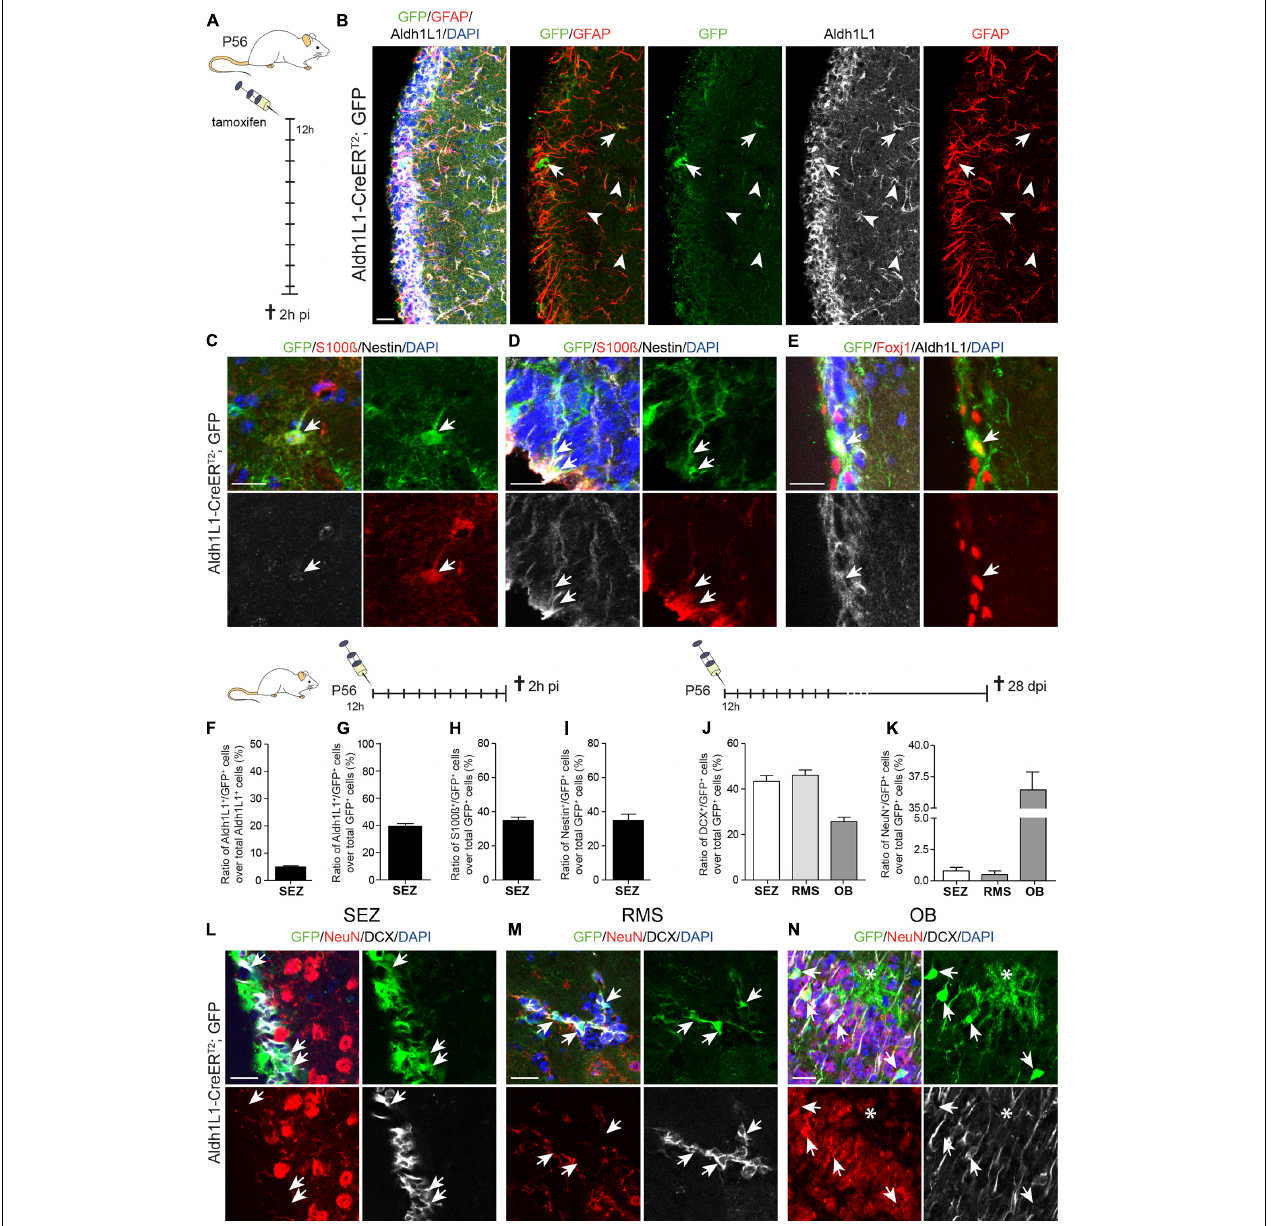
FIGURE 3 | Recombination in Aldh1L1-CreER T2 ; GFP mice targets astrocytes and neural stem cells in the subependymal zone. (A) Schematic drawing showing the short-term tamoxifen pulse. Here, Aldh1L1-CreER T2 ; GFP mice were injected with tamoxifen every 12 h (12 h) for five consecutive days and killed 2 h post-injection (2 h pi). (B) Representative pictures illustrate an overview of the immunohistochemically stained SEZ of adult Aldh1L1-CreER T2 ; GFP mice. Arrows point toward GFP/GFAP/Aldh1L1 triple positive cells while arrowheads highlight non-recombined GFAP + /Aldh1L1 + cells (DAPI in blue, GFP in green, GFAP in red, Aldh1L1 in white; scale bar = 20 µ m). (C,D) Representative images show an immunohistochemically stained SEZ of Aldh1L1-CreER T2 , GFP transgenic mice using antibodies directed against GFP (green), S100 β (red), and Nestin (white). The arrows point toward a GFP/S100 β double positive astrocyte in the SEZ (C) , or a triple positive radial glia-like NSC (D) DAPI is depicted in blue, scale bar = 20 µ m. (E) Images show an immunohistochemically stained SEZ of Aldh1L1-CreER T2 , GFP transgenic mice using antibodies directed against GFP (green), FoxJ1 (red), and Aldh1L1 (white). The arrows point toward a triple positive ependymal cell. DAPI is depicted in blue, scale bar = 20 µ m. (F,G) Efficiency and specificity of recombination are expressed as the ratio of Aldh1L1/GFP double positive cells over all Aldh1L1 + or GFP + cells, respectively (mean + SEM; 2 h pi). (H) Graph showing the ratio of S100 β /GFP double positive cells over all recombined (GFP + ) cells (mean + SEM; 2 h pi). (I) Graph showing the ratio of Nestin/GFP double positive NSCs over all recombined (GFP + ) cells (mean + SEM; 2 h pi). (J–N) Using the long-term tamoxifen protocol (28 dpi) and immunohistochemical analysis with antibodies against GFP (green), DCX (white) and NeuN (red) we assessed the generation of neuronal progeny from recombined NSCs in the SEZ (L) , the RMS (M) and the OB (N) . Data in panels (J,K) represents mean + SEM. Arrows point toward GFP + cells co-expressing either DCX (L,M) or NeuN (N) . Asterisk in panel (N) highlights a recombined astrocyte with protoplasmic morphology in the OB (DAPI is depicted in blue, scale bar = 20 µ